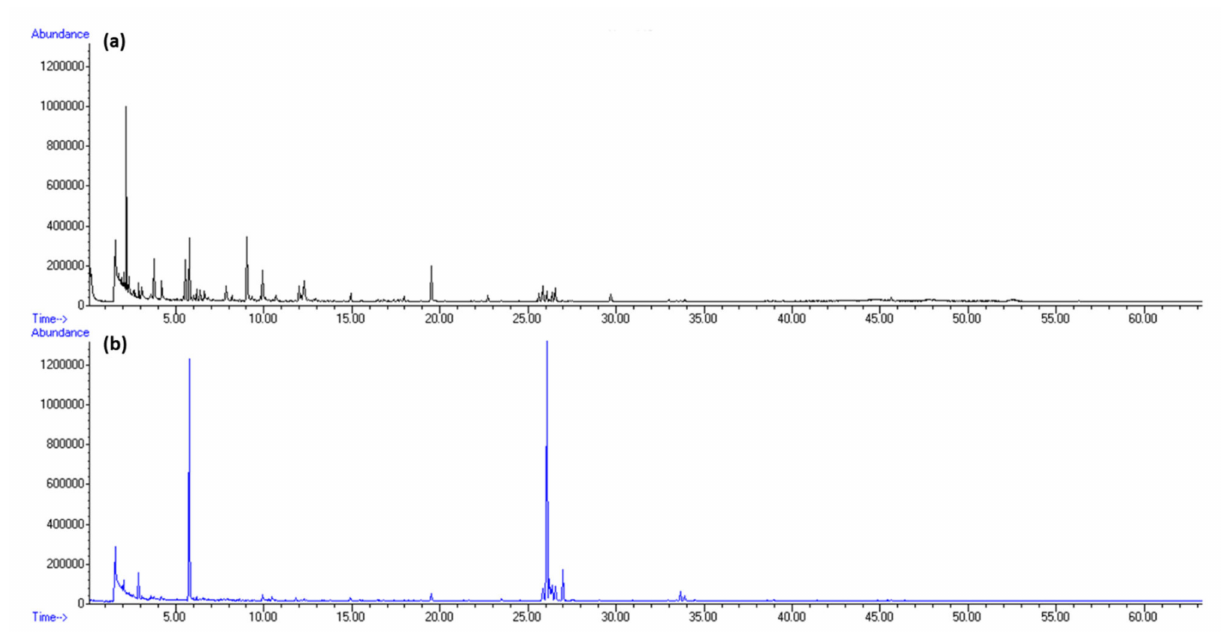
Figure 4. Total ion chromatogram (TIC) comparison of H. scoparia isolated by headspace solid-phase microextraction (HS-SPME) and analysed by gas chromatography–mass spectrometry (GC–MS) using